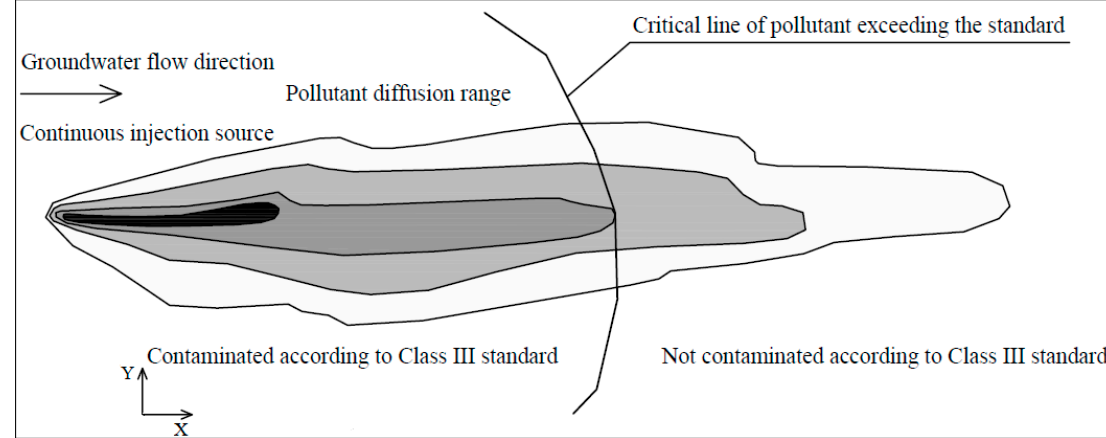
Figure 3. Schematic diagram of contaminant transport.